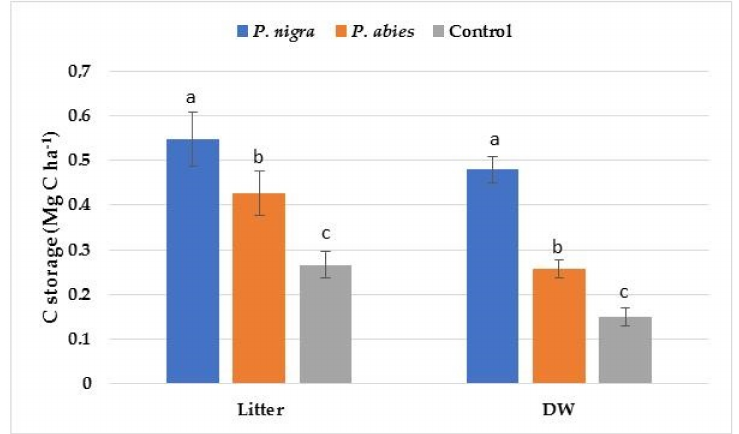
Figure 4. C storage in litter and deadwood (DW) at the study sites. Significant differences among the means at different sites are indicated with lowercase letters by Duncan’s test at α = 0.05; the bars indicate the standard error of the estimate.